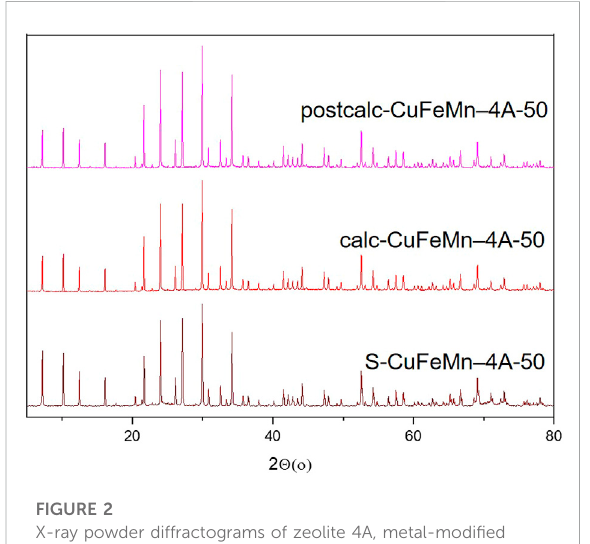
CuFeMn – 4A-50 (squares) and S-CuFeMn-NaZ-50/calc- CuFeMn – NaZ-50 (circles) samples. Black plots show as- synthesized materials whereas red plots calcined (post-) materials. Full symbols — adsorption pointes, empty symbols -